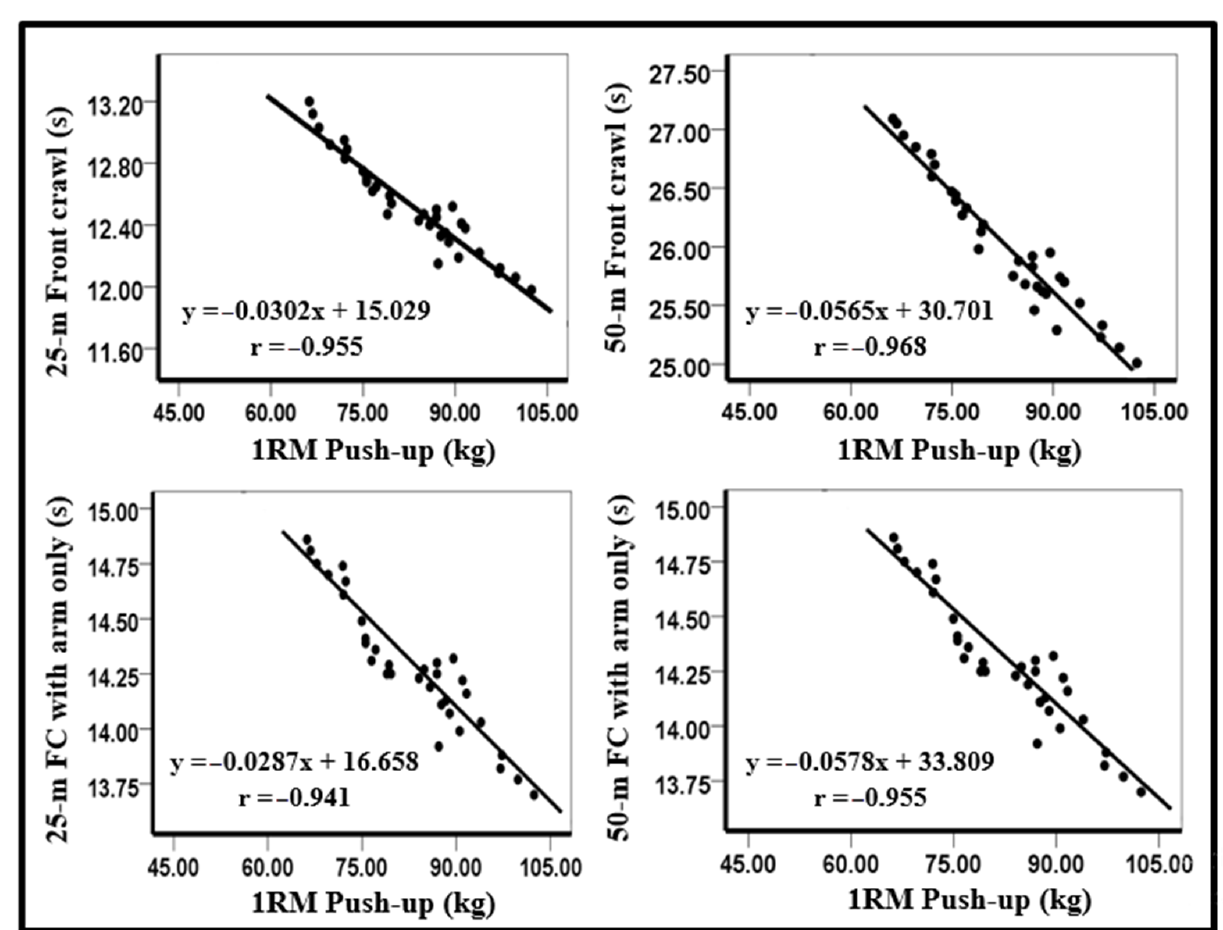
Figure 3. Relationship between swimming performance and the calculated predicted 1-RM push-up. FC: front crawl. Furthermore, significant nearly perfect correlations were observed between the 1RM push-up and the kinematical variables velocity (r = 0.96), stroke length (r = − 0.93), and stroke rate (r = 0.96) in the 50 m front crawl, while a large significant relationship was found between the 1RM push-up and stroke index (r = 0.562, Figure